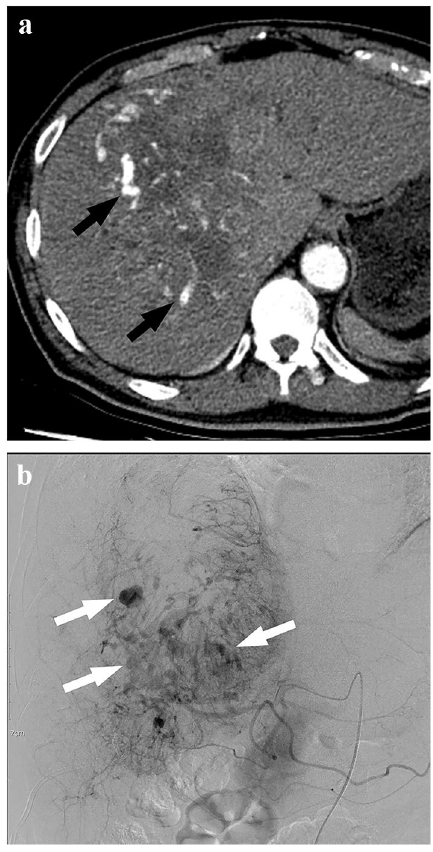
Figure 1. A 67 year old man with hepatocellular carcinoma (size equal to 16 cm). ( a , b ) Arterial phase CT images ( a ) and hepatic arteriography ( b ) revealed multifocal dysmorphic intratumoral vessels with sizes up to 9 mm (arrow). The lung-shunt fraction was 44.74%.